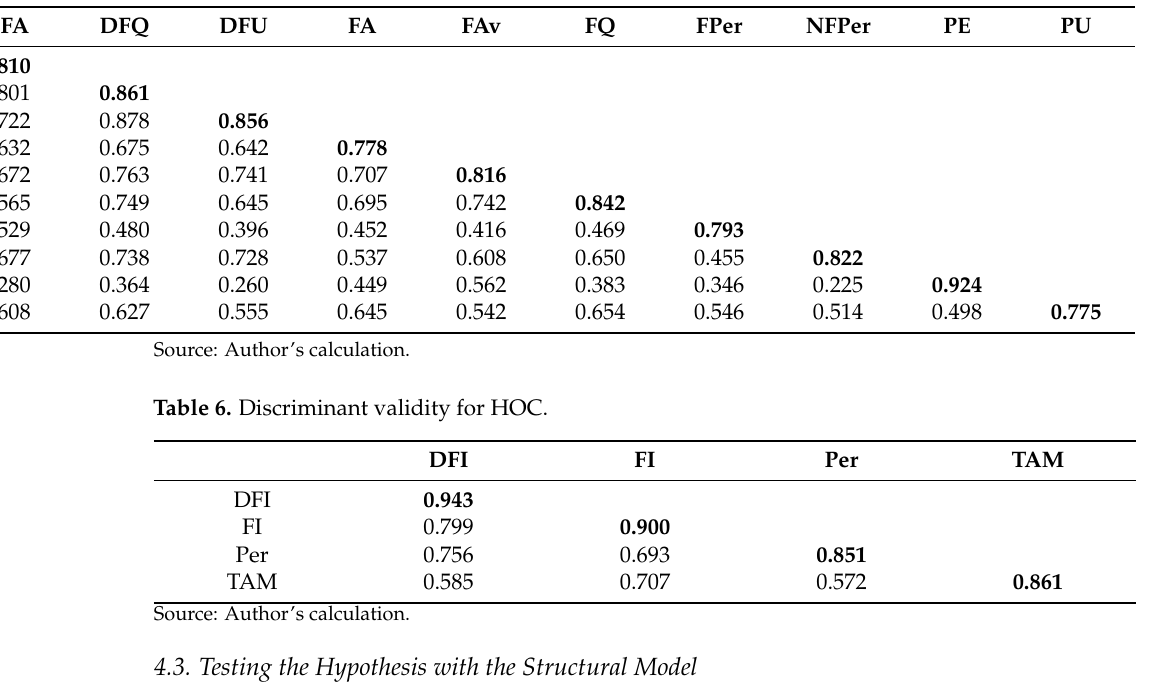
Table 5. Discriminate validity for LOC.